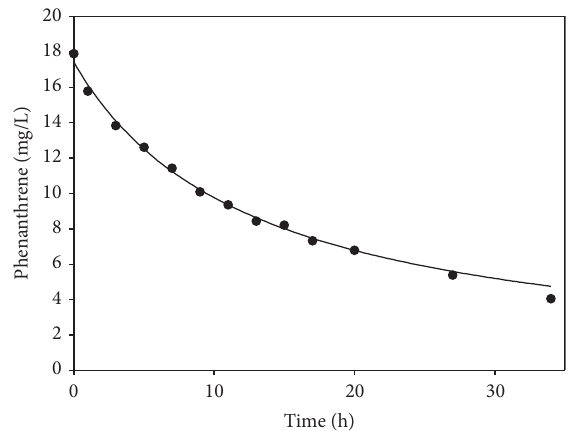
Figure 6: Electro-Fenton degradation of phenanthrene solution (18mg/L). Lines indicate the simulated second-order kinetic